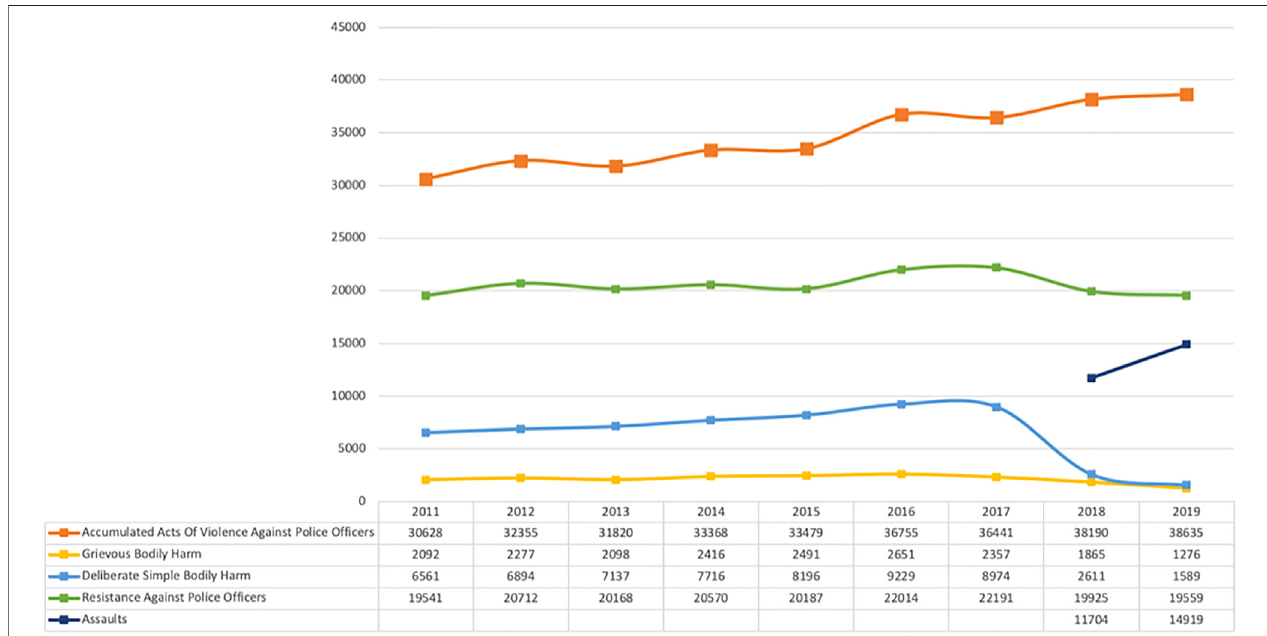
FIGURE 1 | Violence against police of fi cers in Germany by year (data from BKA, 2012 – 2020, own graphic).